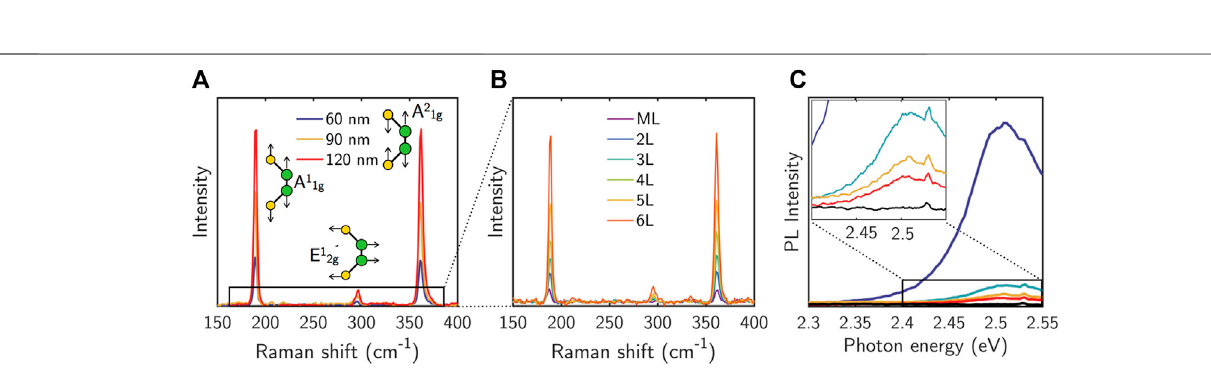
FIGURE3| TypicalRamanspectraof (A) thick GaSand (B) few-layer GaS ragingfrom themonolayer (ML) tosixlayerstransferredontoglass substrates (acquired using a633-nmlasersource). (C) PLspectraofsame sampleswithdifferentthickness acquired irradiating thesamplewitha473-nmlaser.Theblueintensespectrum is for a > 300-nm-thick sample; the black line is for the 1 – 6 L samples. Intermediate states are for layers with a thickness of ≈ 300 nm.